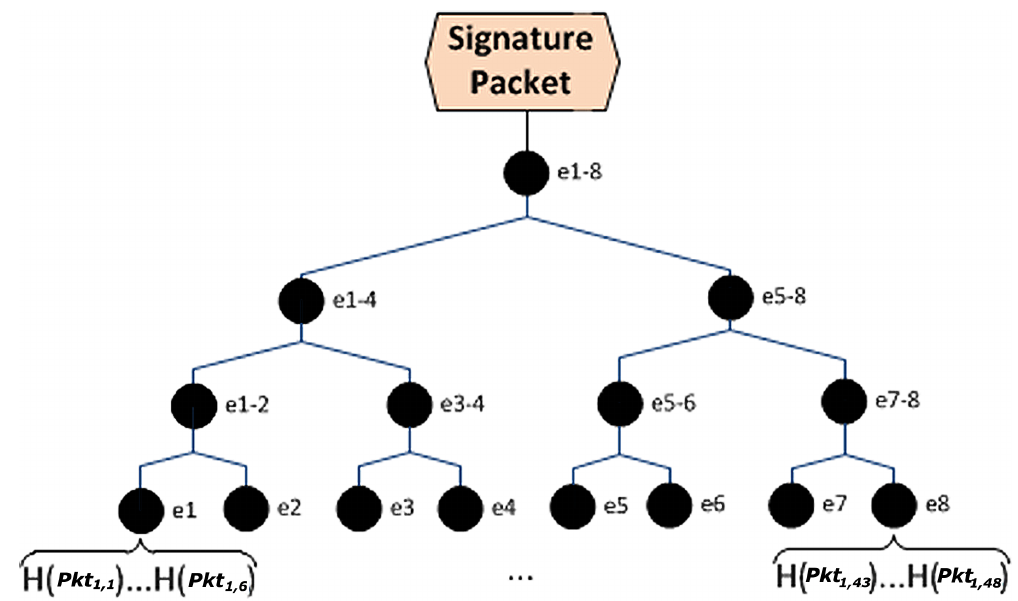
Figure 2. The structure of the Merkle hash tree used in Seluge (adapted from [12]).